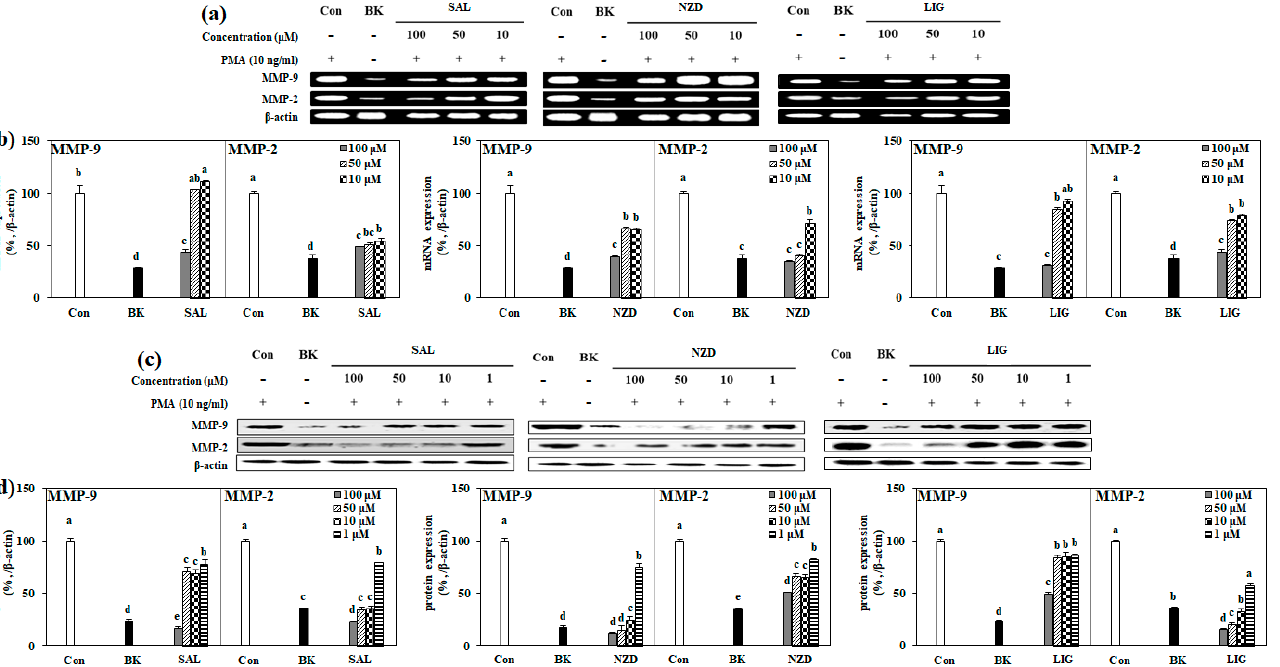
Figure 5. Effects of SAL, NZD and LIG on mRNA ( a , b ) and protein ( c , d ) expression levels of MMP-9 and MMP-2, analyzed by RT-PCR and immunoblotting in HT1080 cells, respectively (Con: untreated PMA-stimulated cells; BK: untreated unstimulated cells). β -actin was used as the loading control. HT1080 cells were treated with compounds prior to stimulation with PMA. The mRNA and protein expression levels of MMP-9 and MMP-2 were densiometrically calculated and given as a relative percentage of the stimulated untreated control group (Con). Expression levels were normalized against housekeeping control, β -actin. a-e Means with different letters at the same concentration are significantly different ( p < 0.05), as assessed by Duncan’s multiple range test.